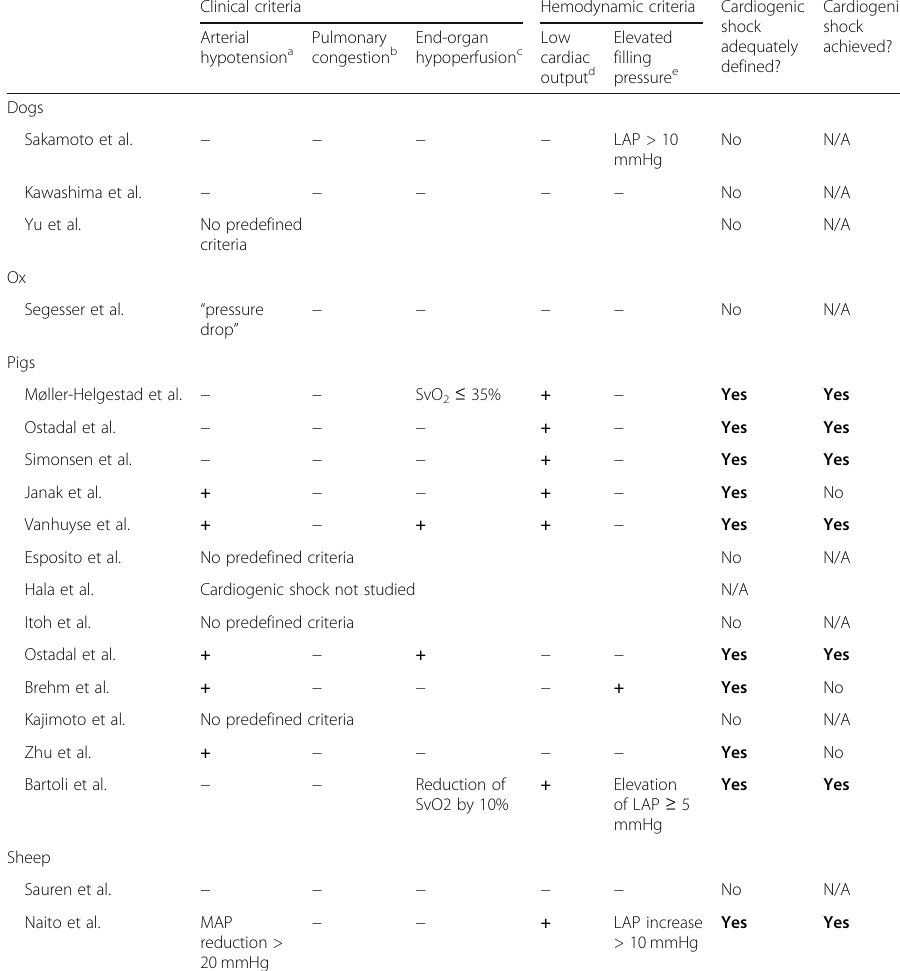
Table 2 Criteria used to define cardiogenic shock adapted to animal